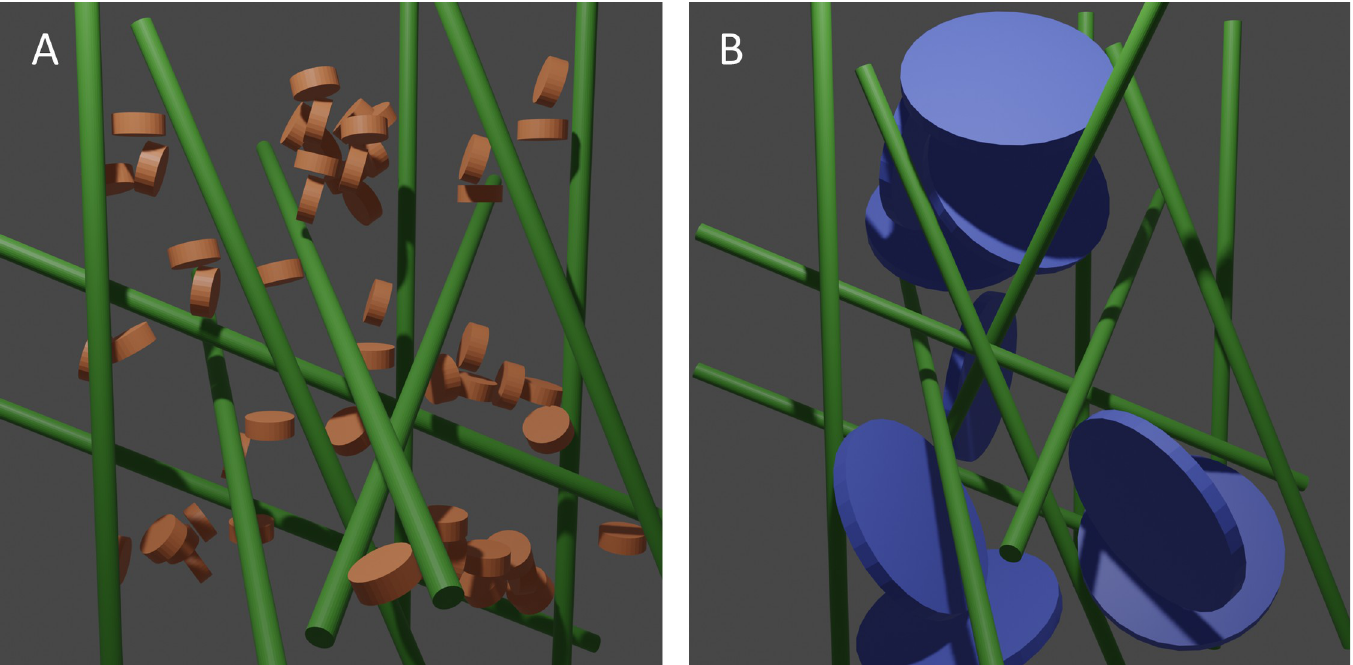
Fig 7. Graphical illustration of the cellulose fibril and clay interactions. Laponite (A) and montmorillonite (B) clay particles interact with the cellulose nanofibrils (green). Aggregates of the smaller laponite particles are more able to fit into and interact with the OCNF network than the much large aggregates of montmorillonite which leads to stronger interactions and more ‘gel-like’